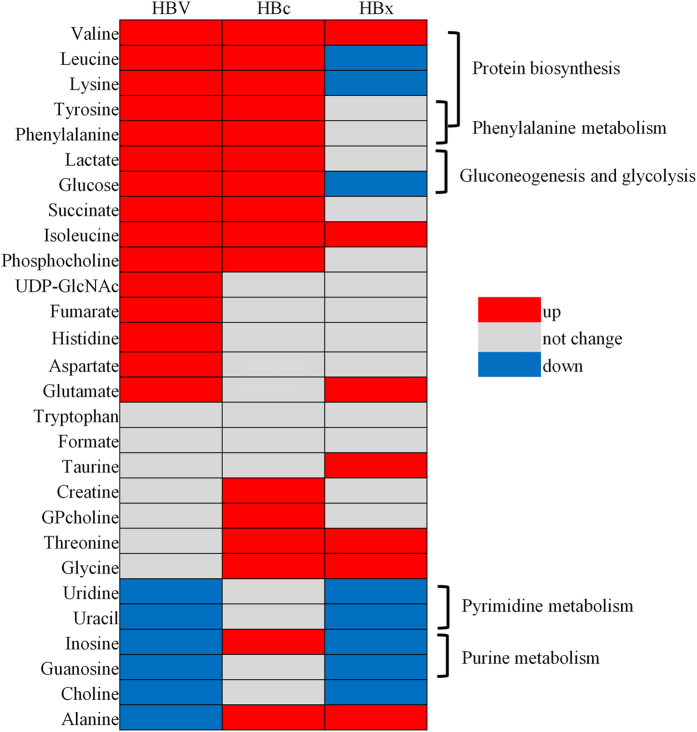
Comparison of metabolic patterns between HBV and its encoded genes.The metabolomics datasets were collected from our study and published papers2324. The metabolites jointly identified by these studies were selected and analysed here. The significantly up- or down-regulated metabolites (*p < 0.001) are indicated by red or blue, respectively.